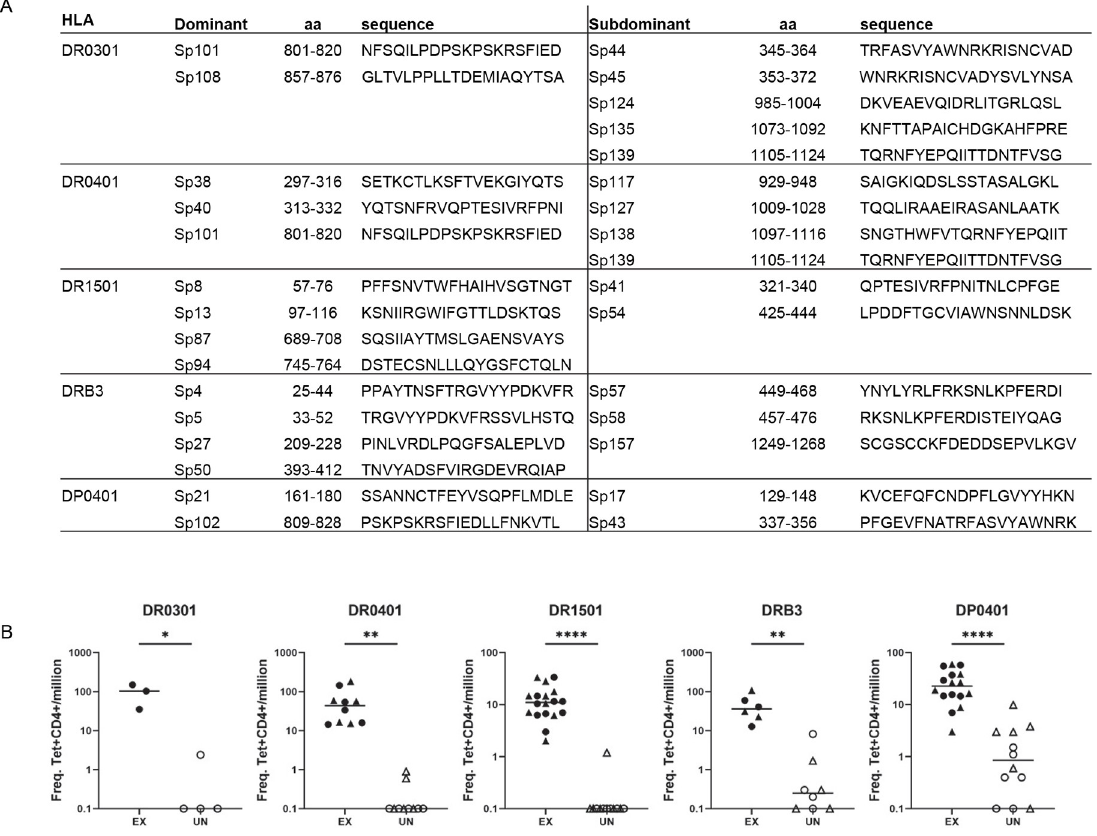
Fig 2. Dominant and subdominant epitopes. (A) Table of dominant and subdominant epitopes for indicated HLAs used in this study. (B) Frequency of T cells specific for dominant epitopes of SARS-CoV-2 exposed (Ex) and unexposed (UN) individuals for each HLA. DR0301 Sp101/Sp108 (circle); DR0401 Sp38/Sp40 (circle), Sp101 (triangle); DR1501 Sp8/Sp13 (circle), Sp87/Sp94 (triangle); DRB3 Sp4/ Sp5 (circle), Sp27/Sp50 (Triangle); DP0401 Sp21 (circle), Sp102 (triangle). Student’s unpaired t-test; � p � 0.05, �� p � 0.01, ��� p � 0.001, ���� p �